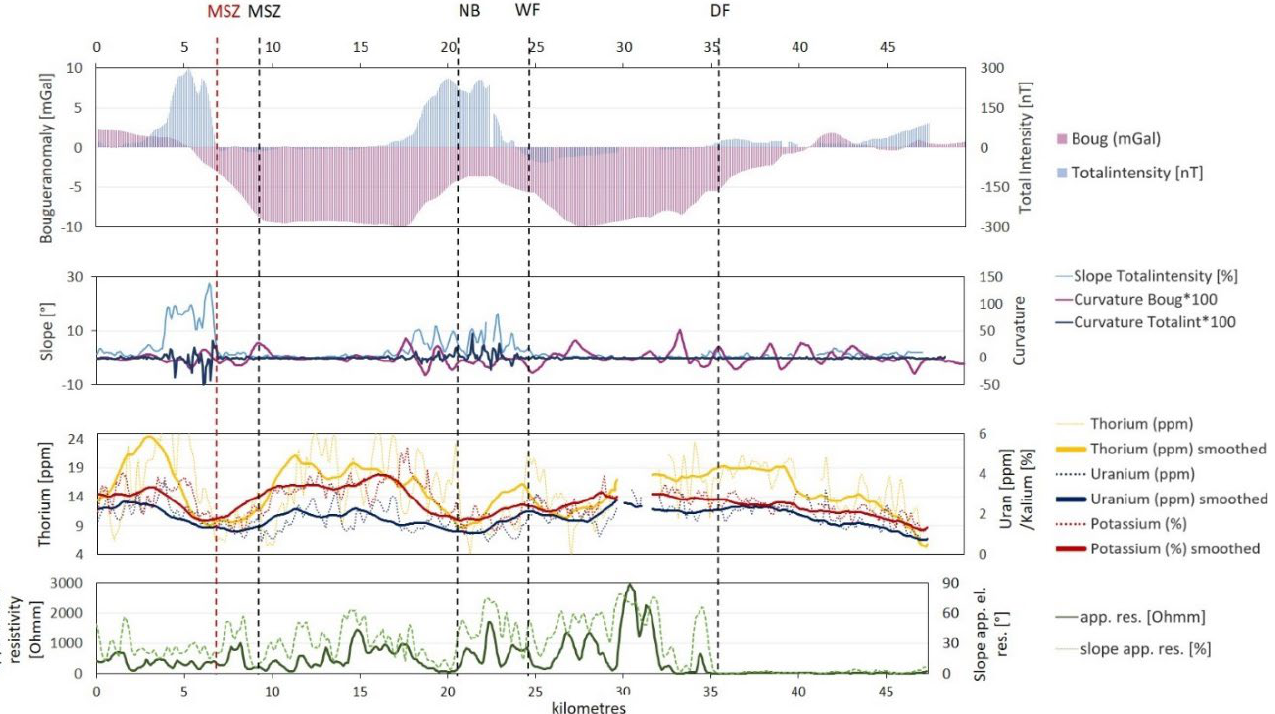
Figure 12. Comparison of different geophysical datasets and their respective derivatives with the position of mapped geological faults along profile A. Locations of the major faults visible in the tectonic map (Figure 1b) are marked by vertical black dashed lines (MSZ = Moldanubian Shearzone, NB = nappe boundary, WZ = Waitzendorf Fault, DF = Diendorf Fault). The vertical red dashed line indicate the position of MSZ based on the common shifts within the presented data and their derivations, most probably due to a westward inclination of the respective fault